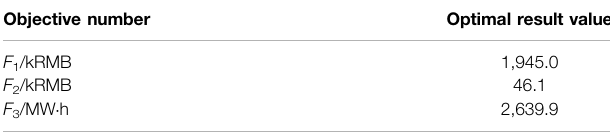
TABLE 6 | Objective values under multi-objective optimization.